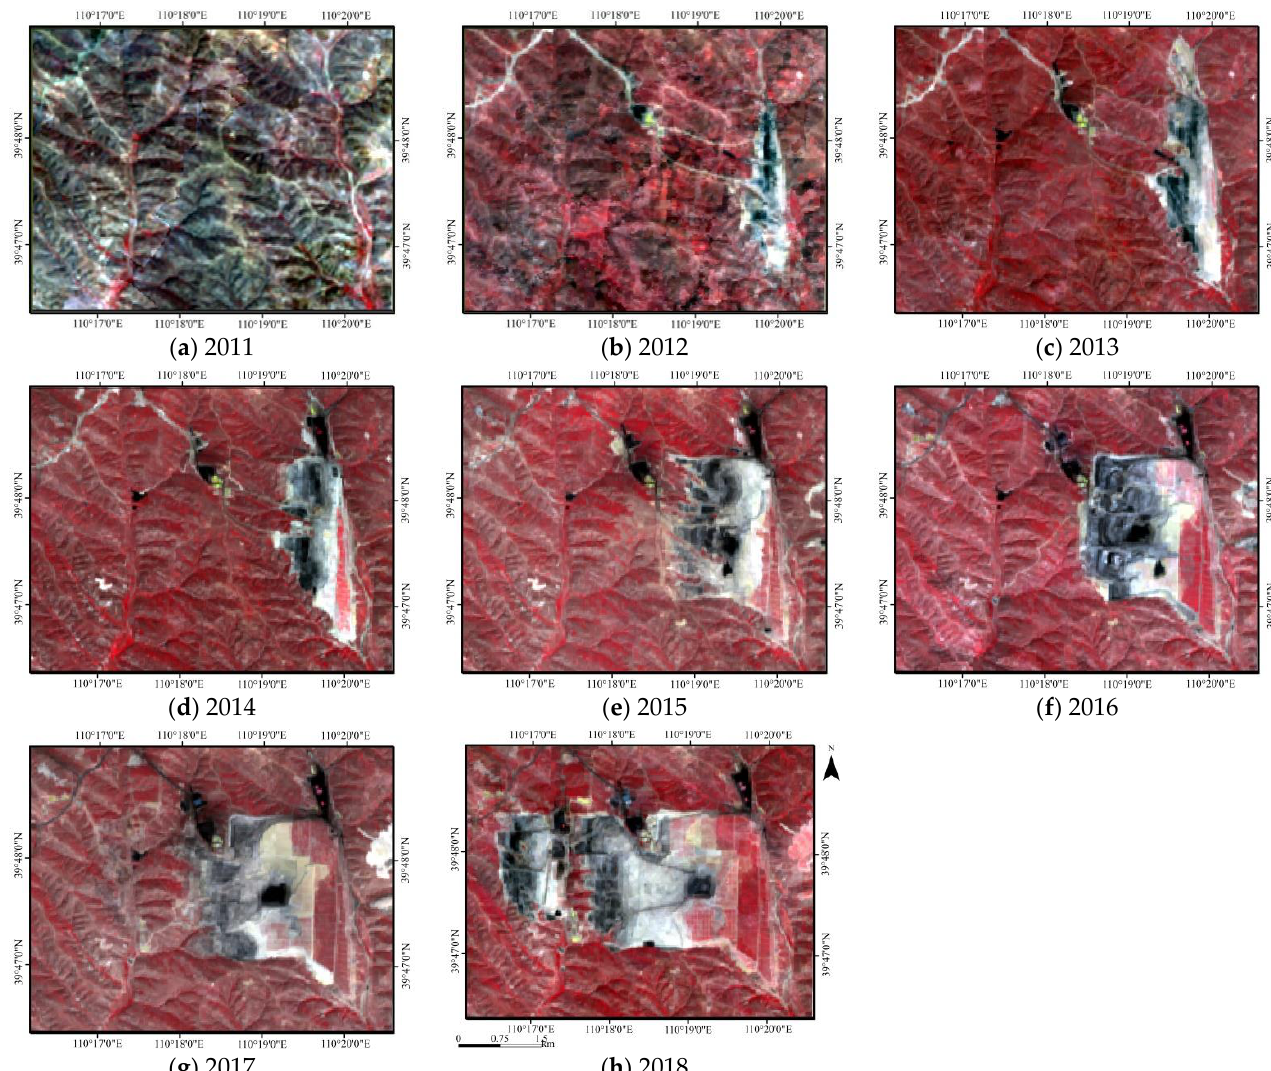
Figure 4. Landsat false-color images of study region from 2011 to 2018.